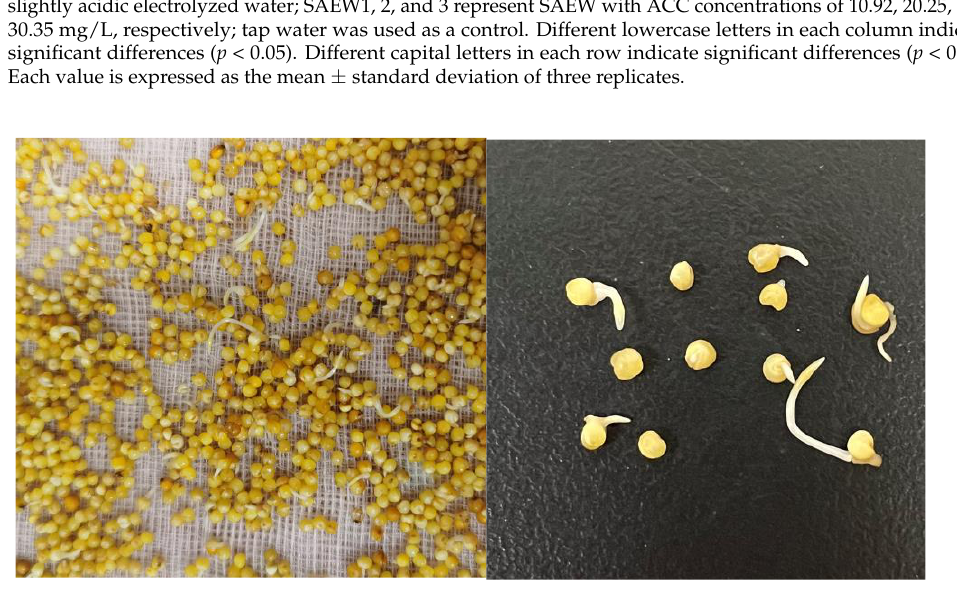
Figure 1. Germinated foxtail millet (germination for 60 h with salt